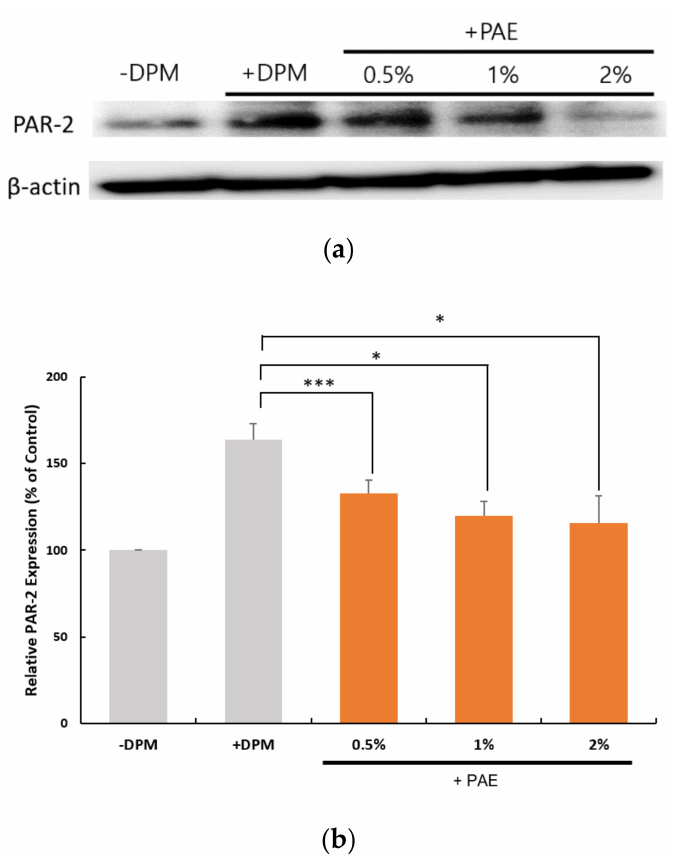
Figure 4. DPM and PAE modulated PAR-2 expression in opposite ways. ( a ) Western blot showed a robust increase in the PAR-2 protein caused by DPM in HaCaT cells, and the treatment with PAE was able to reverse the effect of DPM in a concentration-dependent manner. ( b ) Transcriptional regulation of PAR-2 was demonstrated to be upregulated by DPM, which could be inhibited by PAE. (* p < 0.05, *** p <